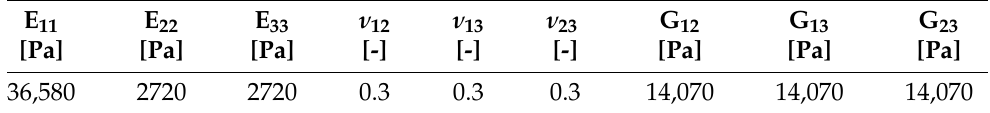
Table 2. Elastic Properties of the CFRP